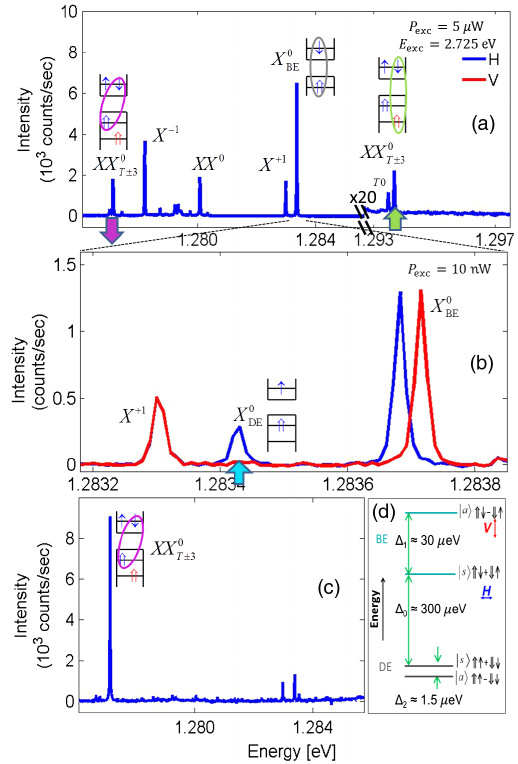
FIG. 1. Photoluminescence spectra of the single QD observa- tion of light emission from the DE. (a) PL spectrum of the QD used in this research excited by high-intensity ( 5 μ W) cw light. The lines are named by their initial states from which the radiative recombination originates. Above the most relevant lines, carrier configurations are schematically displayed. ↑ ( ⇑ ) denotes the electron (heavy-hole) spin state and a short blue (red) arrow denotes s - ( p -)shell single carrier level. Only one of the two possible spin configurations is displayed in each case. The recombining e - h pair is indicated by a matching oval. The spectral line used for detecting (exciting) the XX 0 biexciton T (cid:1) 3 line is marked by downward magenta (upward green) arrow. (b) Polarization-sensitive, expanded scale PL spectrum of the QD at low excitation intensity (10 nW). At this excitation level, the DE spectral line is clearly observed about 300 μ eV below the BE lines. Unlike the BE line, which has two cross rectilinearly polarized components, the DE has one horizontal polarization. (c) PL spectrum from the QD under resonant excitation into the higher-energy optical transition of the XX 0 biexciton line T (cid:1) 3 [upward green arrow in (a)]. (d) Schematic description of the energy fine structure of the QD confined